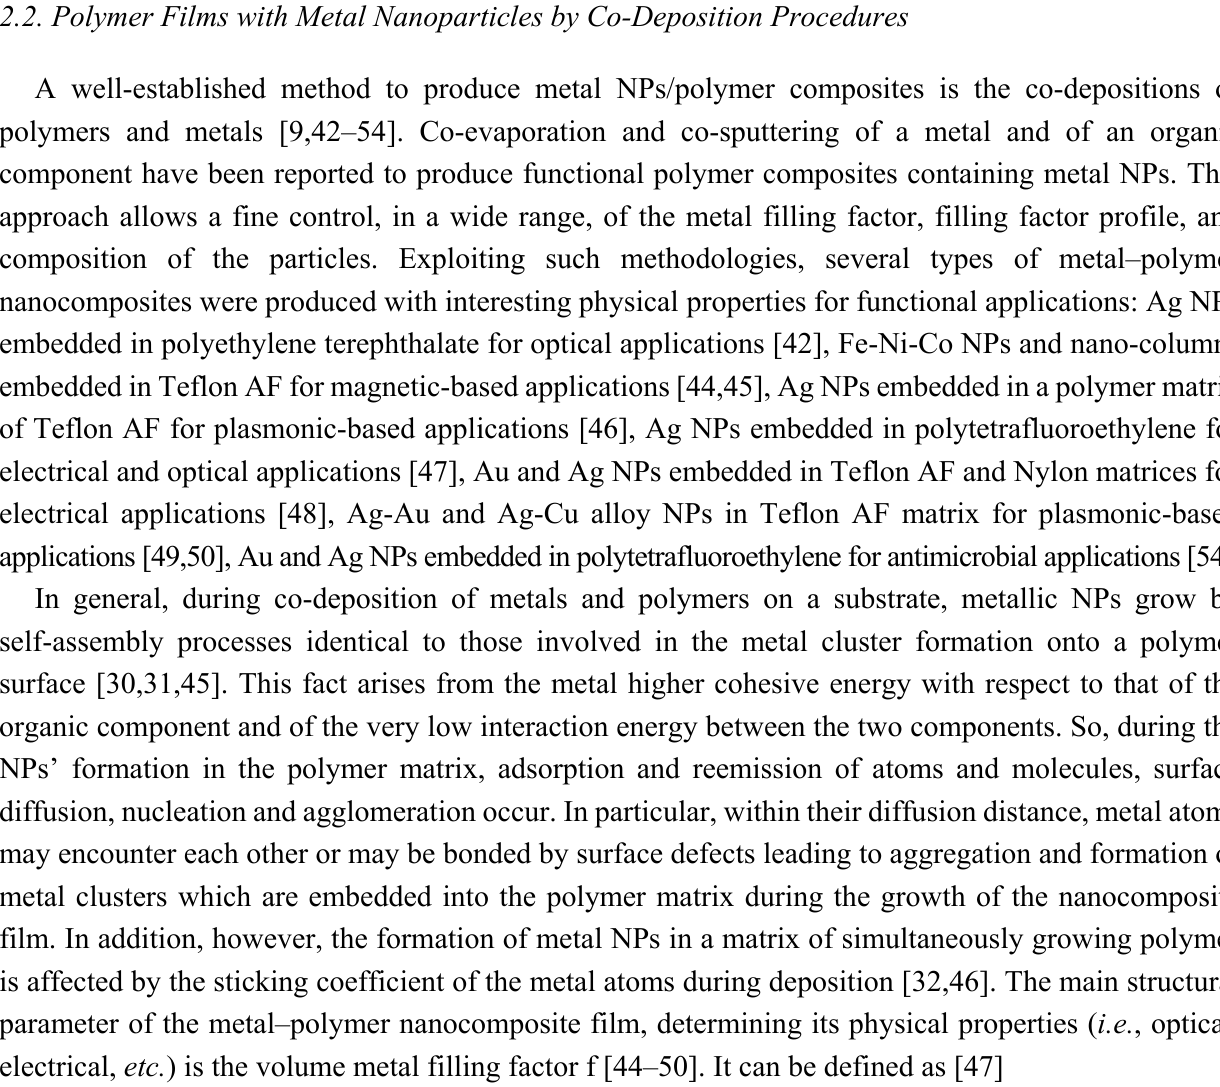
Figure 7. ( a ) lg 10 ( N ) vs. h 2/3 (dots) with least-squares fitting (solid line), for Au on polystyrene (squares) and on poly(methyl methacrylate) (circles); ( b ) Coverage P vs. N / N 0 (dots) with least-squares fitting (solid line), for Au on polystyrene (squares) and on poly(methyl methacrylate) (circles). (Reproduced with permission from [21], Copyright Springer